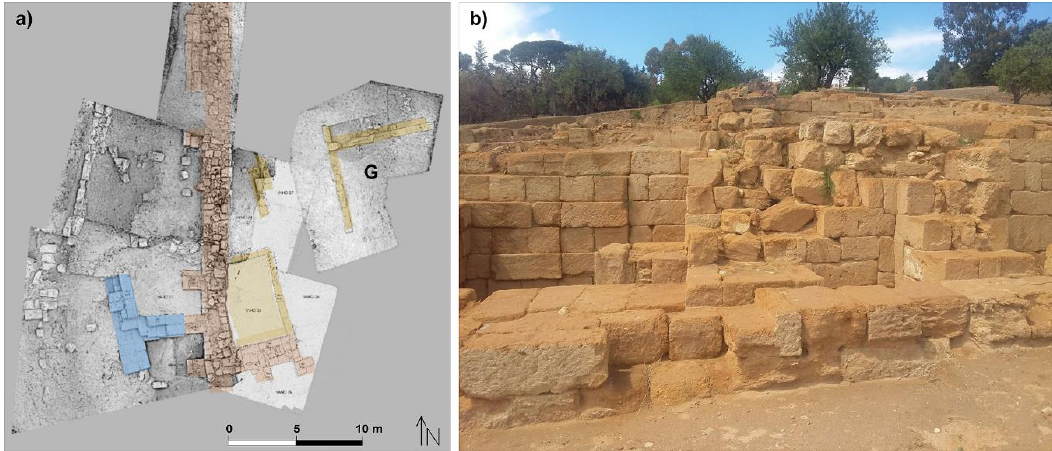
Figure 10. Area 3: grid data acquisition (blue, red, and yellow lines are, respectively, spaced 1, 1.5, and 2 m) ( a ), 3D voxler heightfields maps at 1.5 ( b ), 3 ( c ), and 4.5 m ( d ) in depth and sections of the imaged resistivity volume ( e ).